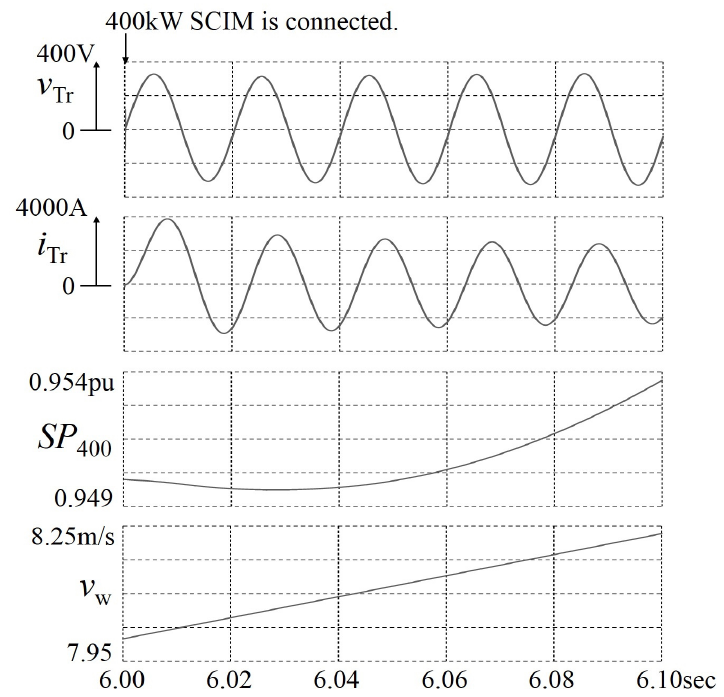
Figure 5. Simulated waveforms of the direct connection for the 400-kW